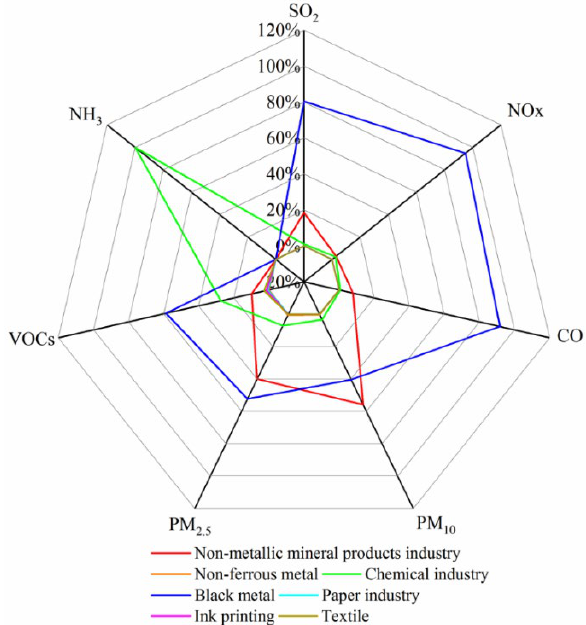
Figure 4. The contribution of each sector in industry process sources.